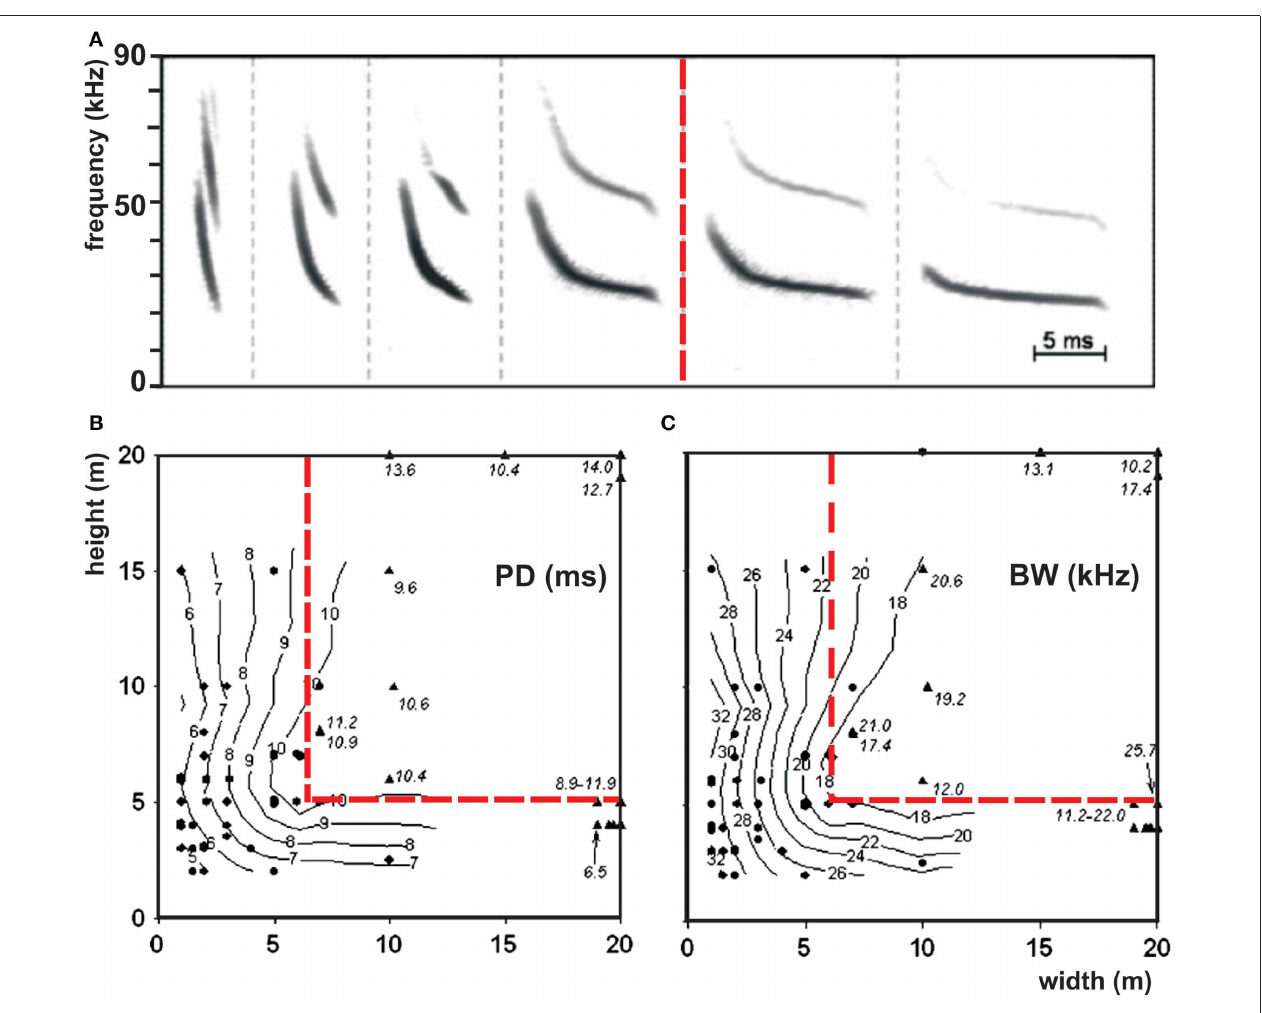
FIGURE 3 | Border between open and edge space. (A) Repertoire of the echolocation signals of Vespertilio murinus while foraging in open (right to the red line) and in edge space (left to the red line) and (B) isocontour plots of the signal parameters pulse duration and (C) bandwidth as a function of the horizontal and vertical distances to the